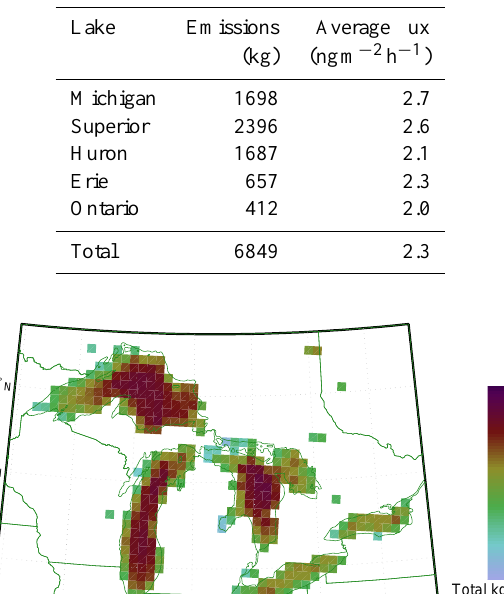
Table 1. Total emissions from lake surface emissions for the 318 days of the measurements for the domains shown in Fig. 2.